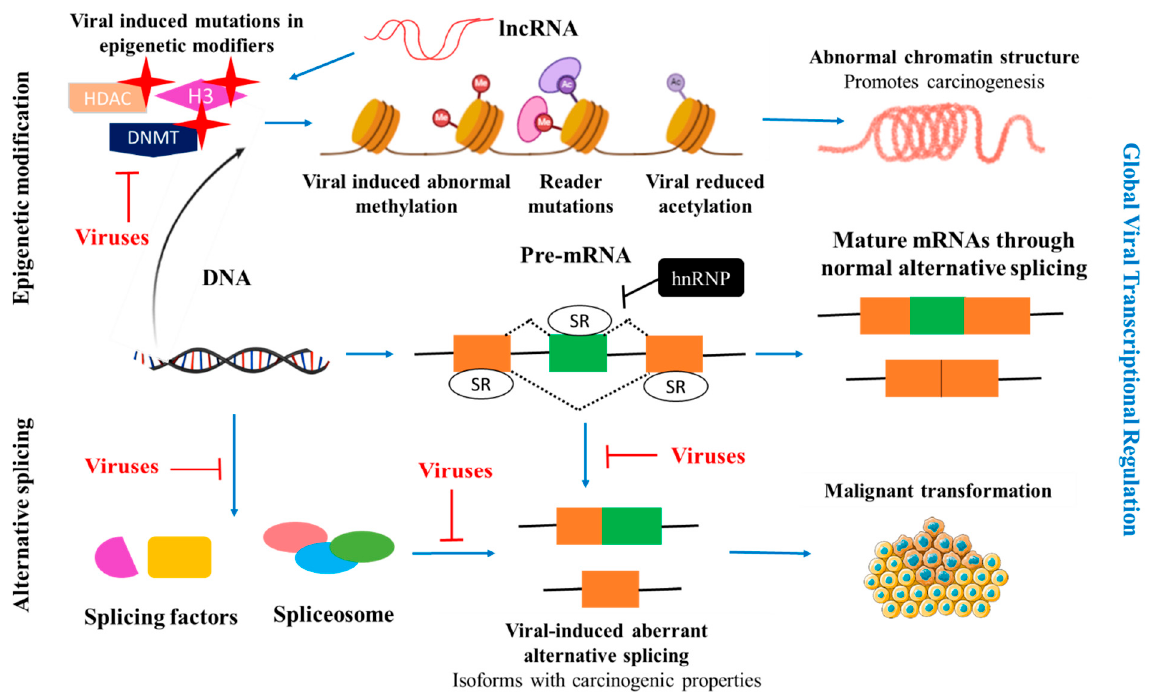
Figure 1. Global virally-induced transcriptional regulation. Viral infections hijack cellular splicing machinery and enhanced epigenetic modifications to promote carcinogenesis through abnormal methylation caused by genetic alterations, histone modification and DNA methylation. Moreover, viral proteins repress the expression and inhibit the binding of splicing factors to modulate aberrant splicing, thereby producing mRNA isoforms with carcinogenic properties that drive cellular transformation [20,26]. hnRNP: heterogeneous ribonucleoproteins; lncRNA: long non-coding RNA; HDCA: Histone deacetylases; DNMT: DNA methyltransferase; H3: Histone H3.